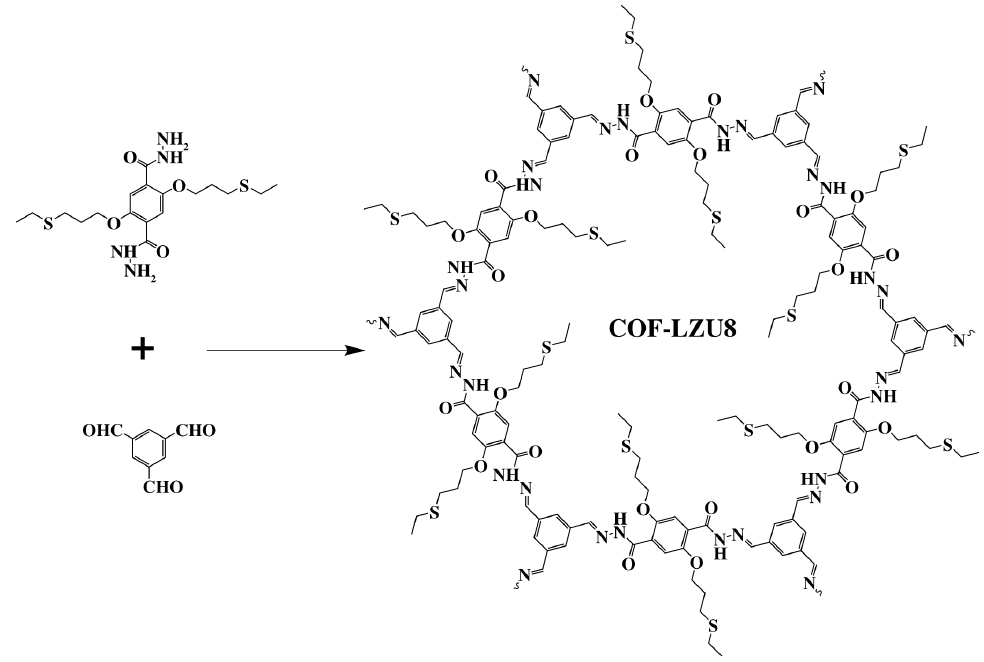
Figure 12: Synthesis and structure of